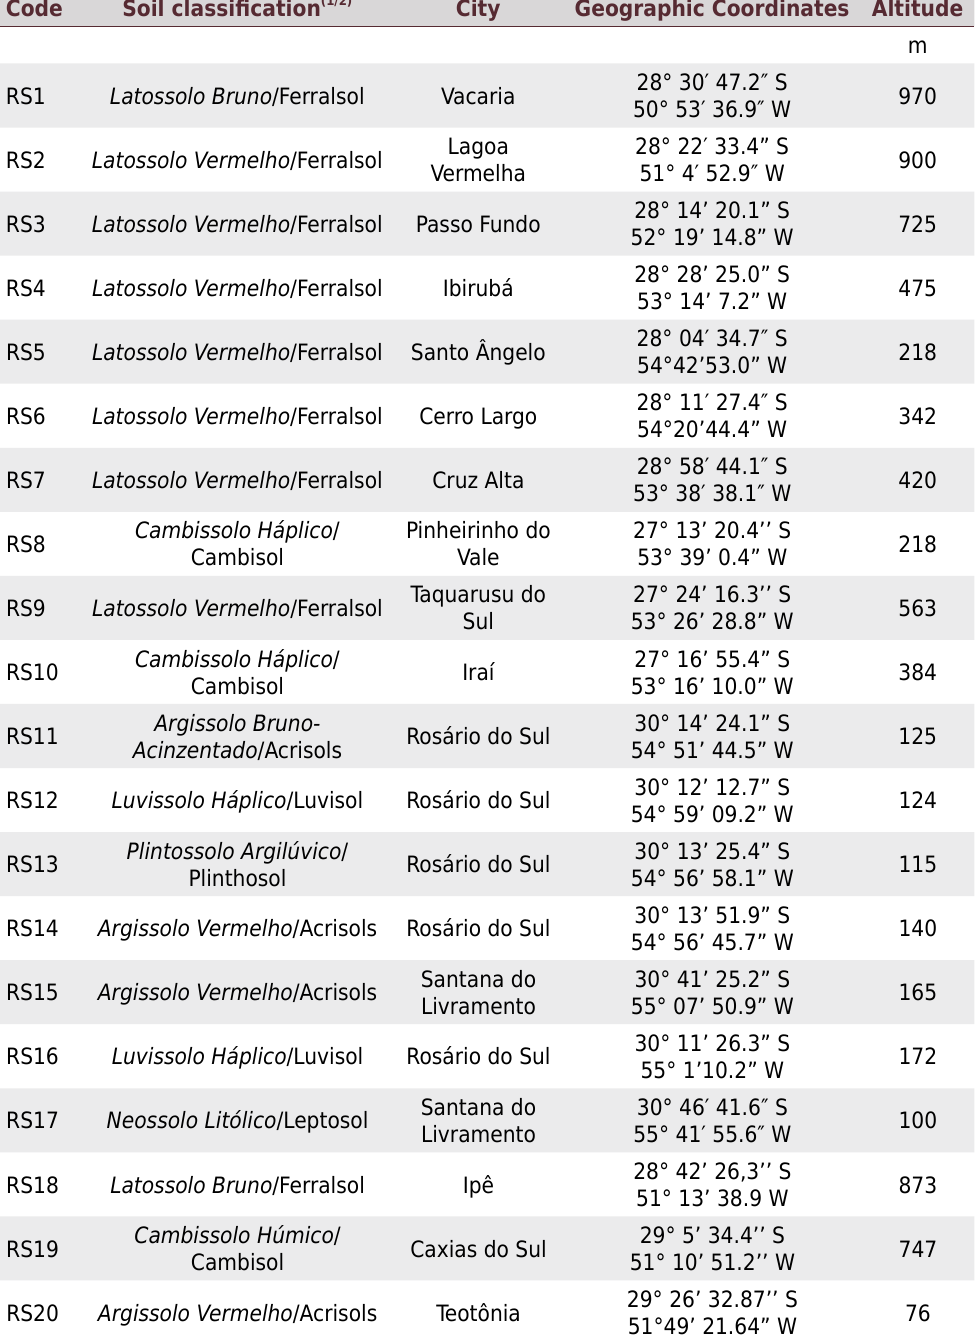
Table 1. Classification and localization of the soils collected in the state of Rio Grande do Sul (RS), Brazil